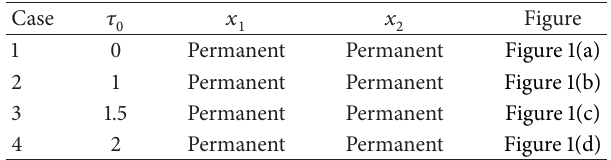
Table 2: Simulations of Model (4).